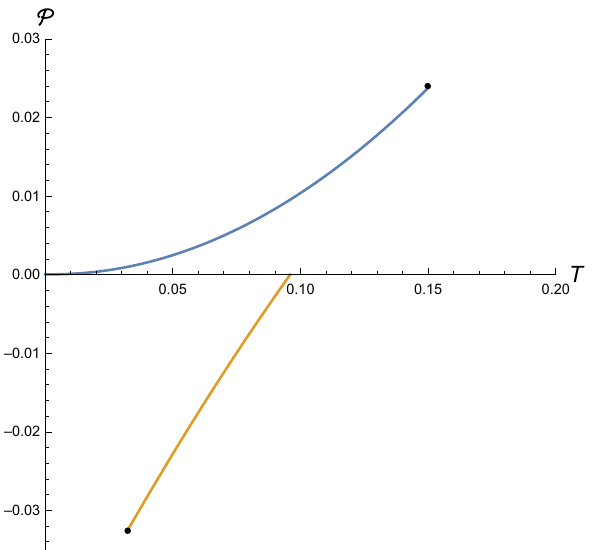
Fig. 5 P – T plane of dilatonic black hole with N = 2 , D = 6. We set the electric charge Q = 10. In the plane, the top and bottom lines represent the positive and negative pressure zones. The black points represent the critical points From Fig. 6, the first intersection of − g tt and g − 1